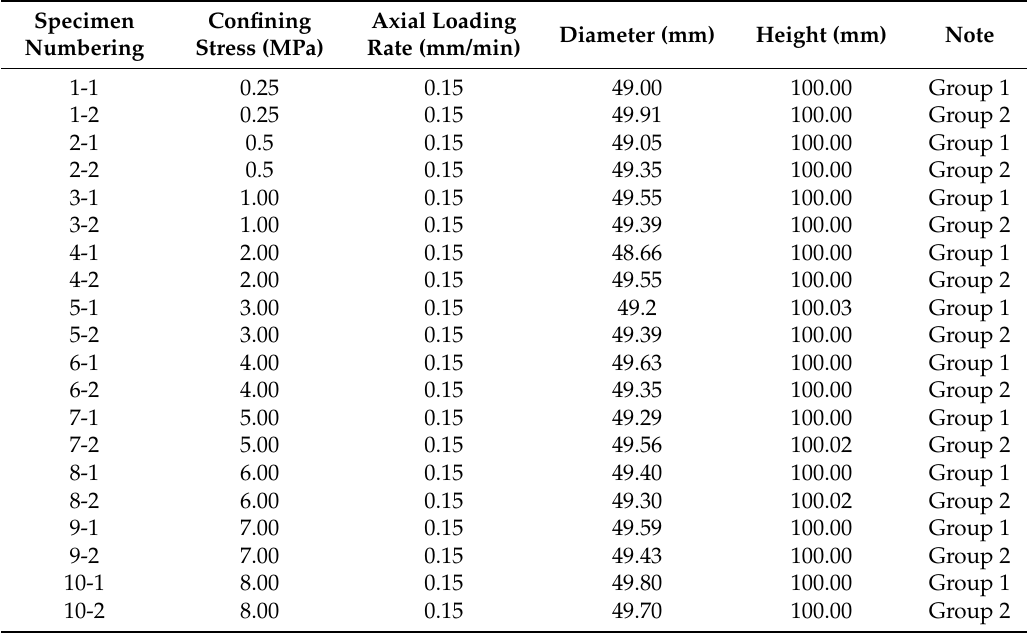
Figure 4. Specimens used for triaxial tests: ( a ) group 1, ( b ) group 2. Table 1. Loading condition and geometric dimension of coal specimens.